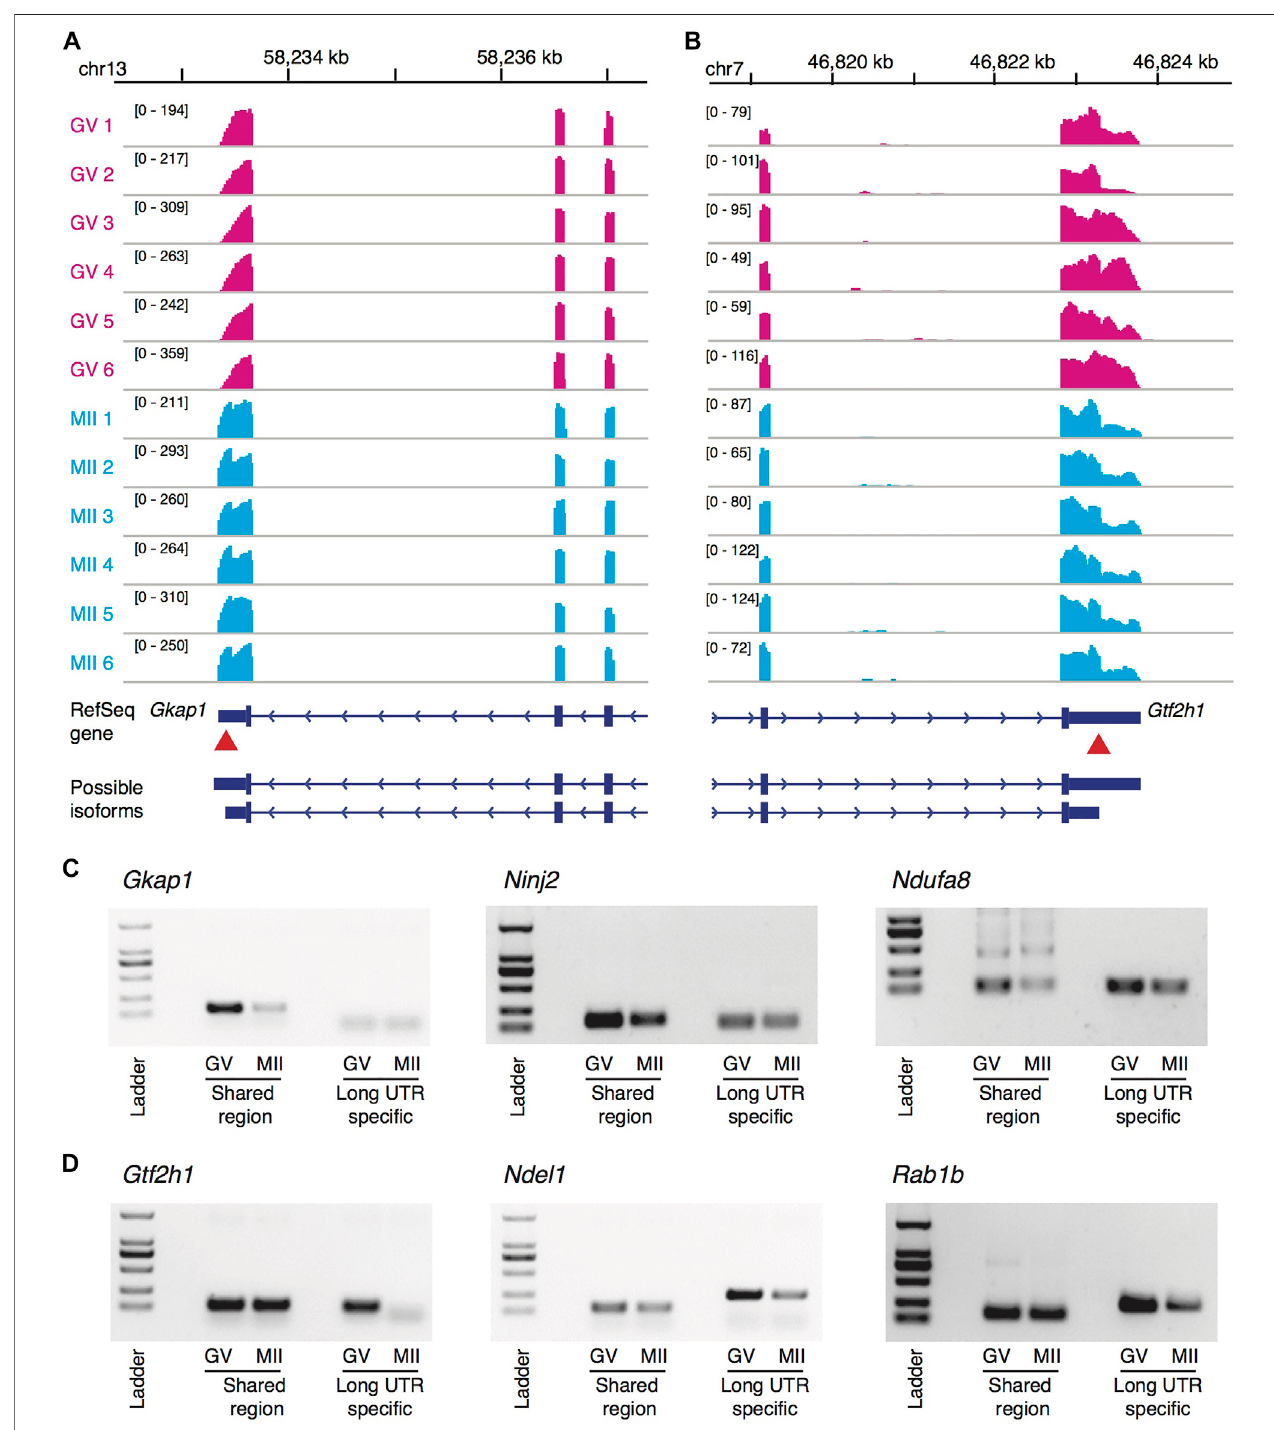
FIGURE4| Genome-browservisualizationandexperimentvalidationof3 ′ -UTRisoformswitches. (A,B) Genome-browservisualizationofthegenes Gkap1 (A) and Gtf2h1 (B) . In each subplot, showing from top to bottom are genomic coordinates, RNA-seq read coverage of 6 GV oocytes (red), RNA-seq read coverage of six MII oocytes (blue), the RefSeq gene annotation, and possible isoforms with alternative polyadenylation sites. The red arrows point out the approximate location of the proximal polyadenylation sites (i.e., the switch points on read coverage between the two stages). (C) Validation of the genes Gkap1 , Ninj2 , and Ndufa8 with longer 3 ′ -UTR isoforms preferred during the oocyte maturation by independent experiments. Taking the shared region as a reference, the long UTR-speci fi c region either showed weaker bands at the GV stage ( Gkap1 and Ninj2 ) or a stronger band at the MII stage ( Ndufa8 ). (D) Similar to (C) , but validation of genes Gtf2h1 , Ndel1 , and Rab1b , which showed the opposite trend in length of the 3 ′ -UTR isoform usage.